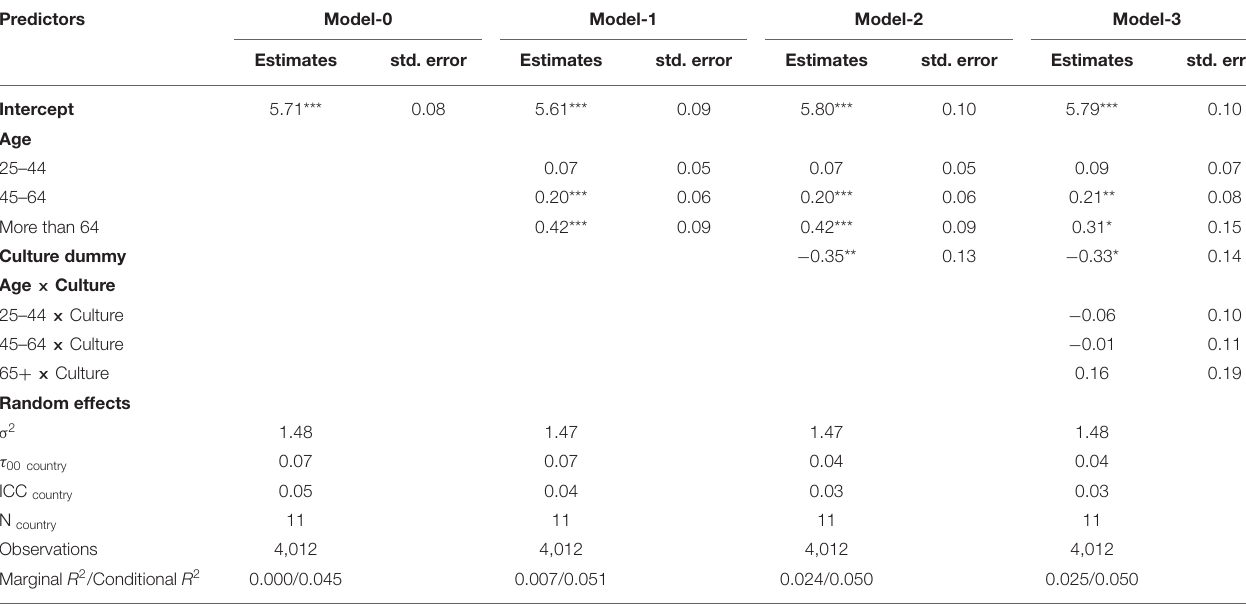
TABLE 7 | Overview of main statistical outcomes of multilevel regression models testing the effects of Age, Culture, and Age × Culture on rated efficiency of music in “ Reducing loneliness and creating a sense of togetherness.”